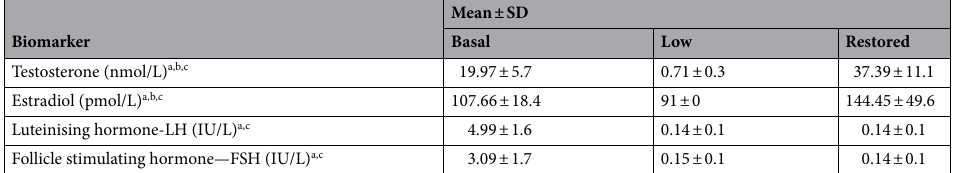
Table 4. Plasma concentration of gonadotropins and sex hormones in the three groups: Basal, Low and Restored testosterone levels. This results were extracted from Sahlin et al 22 . Variables are expressed as mean ± standard deviation. a p value < 0.05, Basal versus Low. b p value < 0.05, Low versus Restored. c p value < 0.05, Basal versus